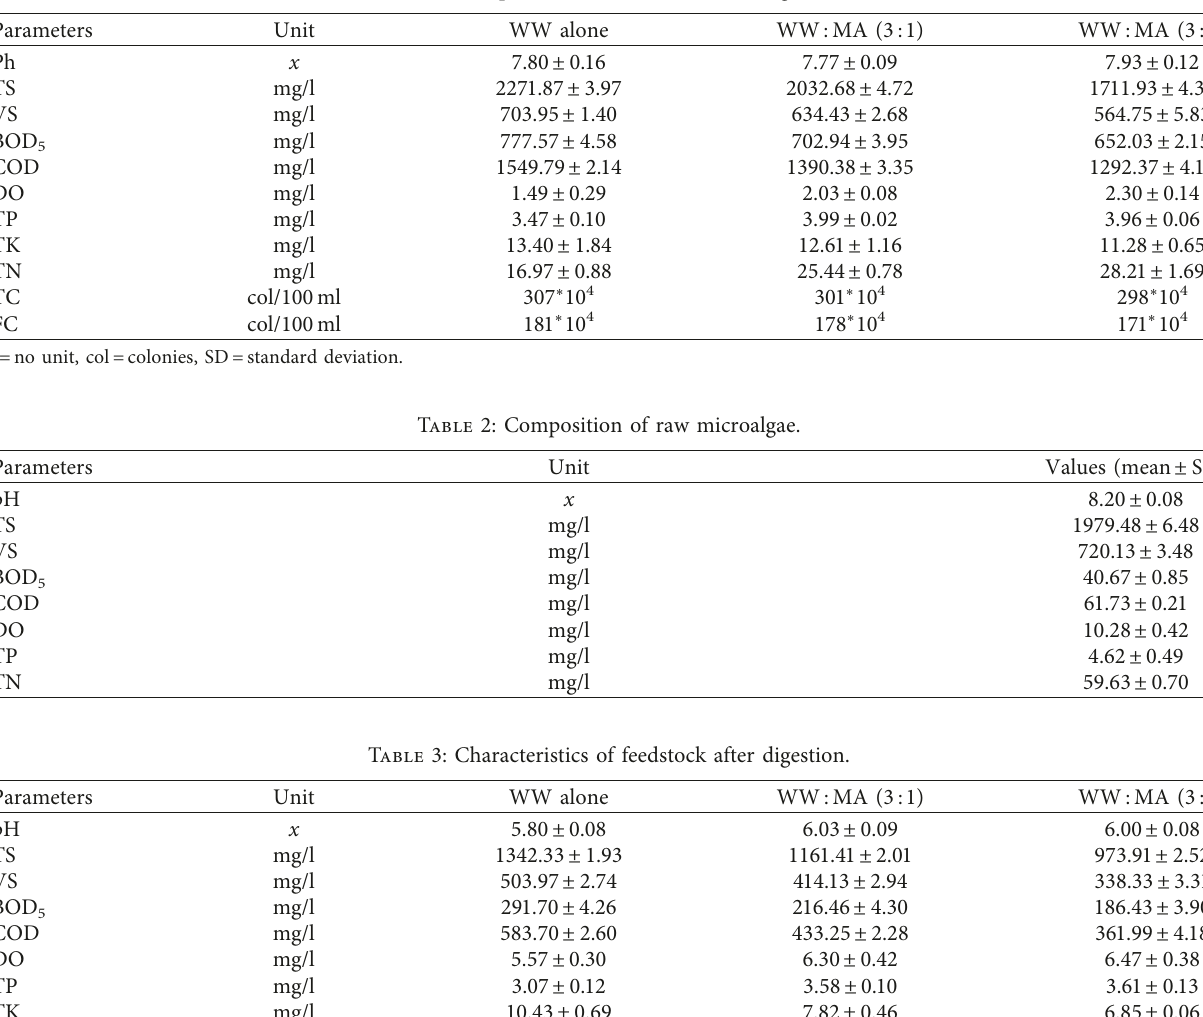
Table 1: Composition of feedstock before digestion.